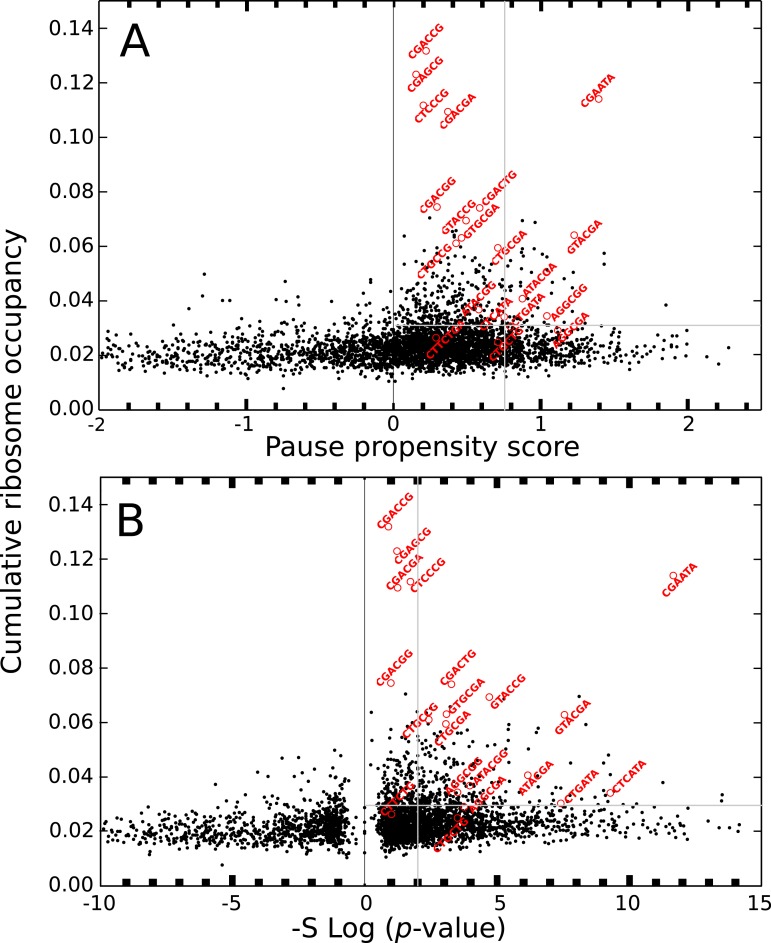
Cumulative ribosome occupancy vs. π score and p-value for S. cerevisiae.(A) Scatter plot of the cumulative ribosome occupancy and the pause propensity scores. (B) Scatter plot of the cumulative ribosome occupancy and quantity −Slog10(p-value). Red circles correspond to the known inhibitor bicodons. Other candidates for modulating transcript elongation rate are indicated in Table S3 by ** (π > 0.75, p-value < 0.01 and cumulative ribosome occupancy >0.03.